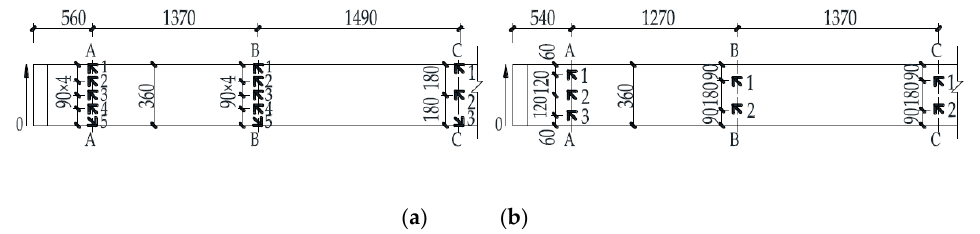
Figure 8. Schematic view of loading configurations: ( a ) Loading points applied in longitudinal direction; ( b ) Loading points applied in radial direction. Figure 9. Arrangements of strain gauges on CSWs on S1-t1d2 and S3-t2d3: ( a ) Outer CSW; ( b ) Inner Figure9. ArrangementsofstraingaugesonCSWsonS1-t1d2andS3-t2d3: ( a )OuterCSW;( b CSW.